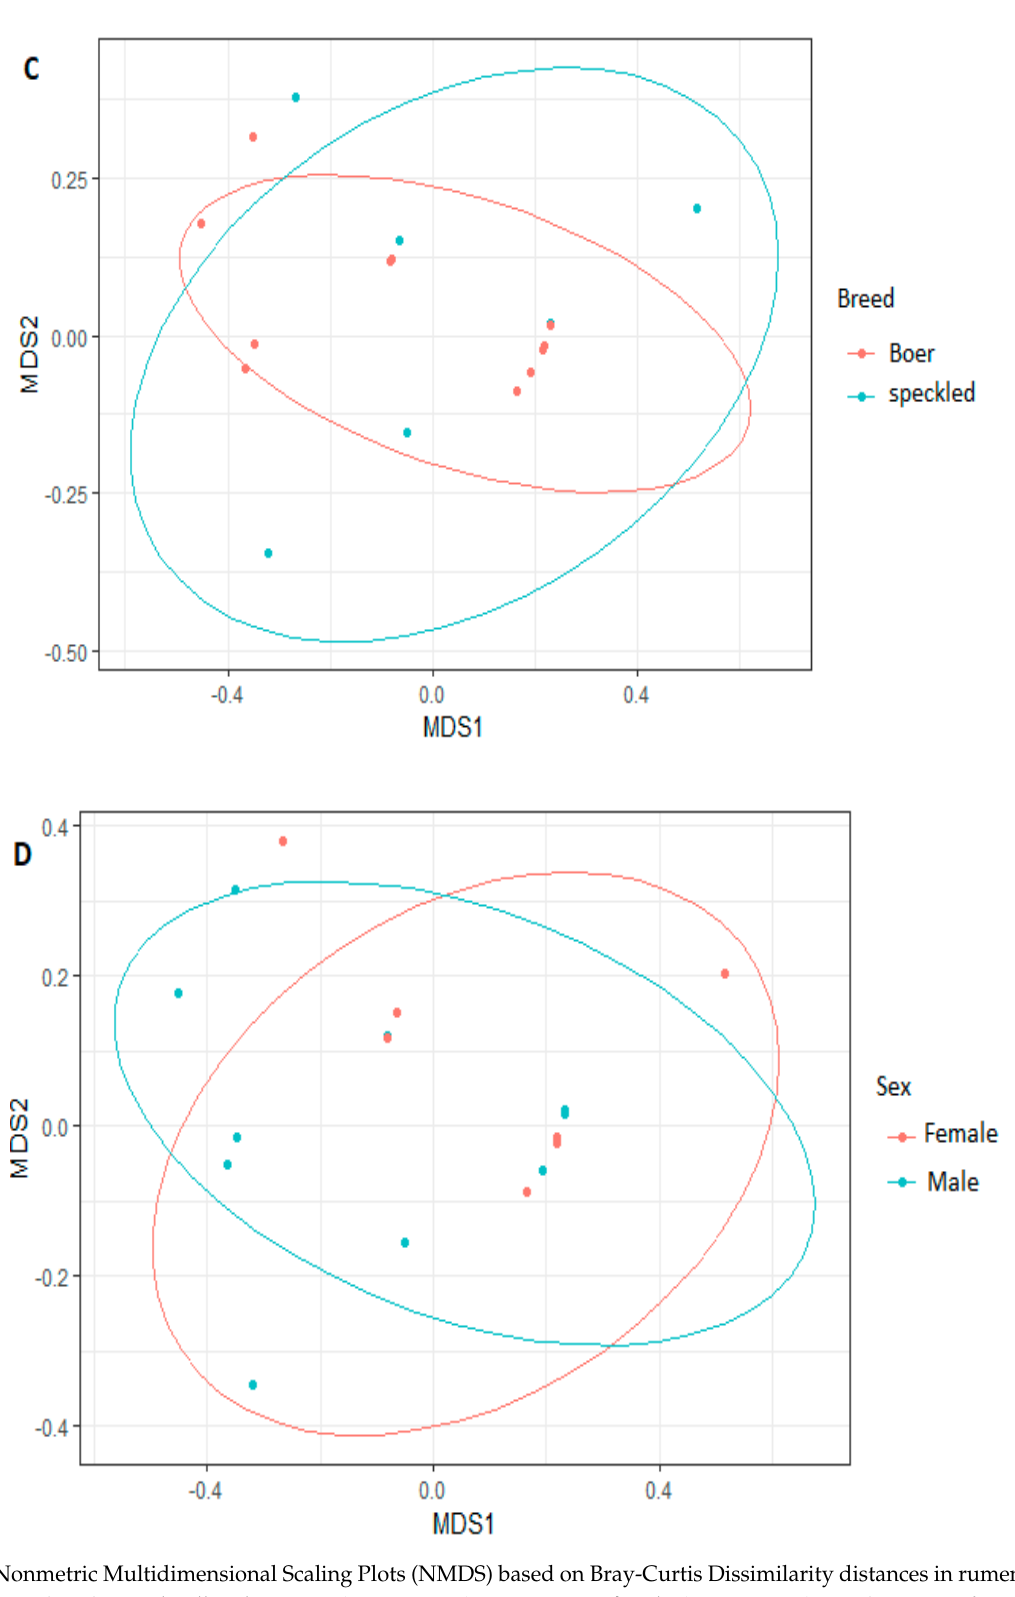
Figure 6. Nonmetric Multidimensional Scaling Plots (NMDS) based on Bray-Curtis Dissimilarity distances in rumen content of goats treated with Lactobacillus rhamnosus (Treatment 1), Enterococcus faecalis (Treatment 2), combination of Lactobacillus rhamnosus and Enterococcus faecalis (Treatment 3), antibiotic (Treatment 4), and negative control (Treatment 5). Each point represents sample and the colours represent; treatment ( A ), sample day ( B ), breed ( C ), sex ( D ). Analysis of similarity (ANOSIM) showed that there were many similarities in micro- bial composition in the rumen across the treatment 1, 2, 4 and 5 (Figure 7A). ANOSIM also